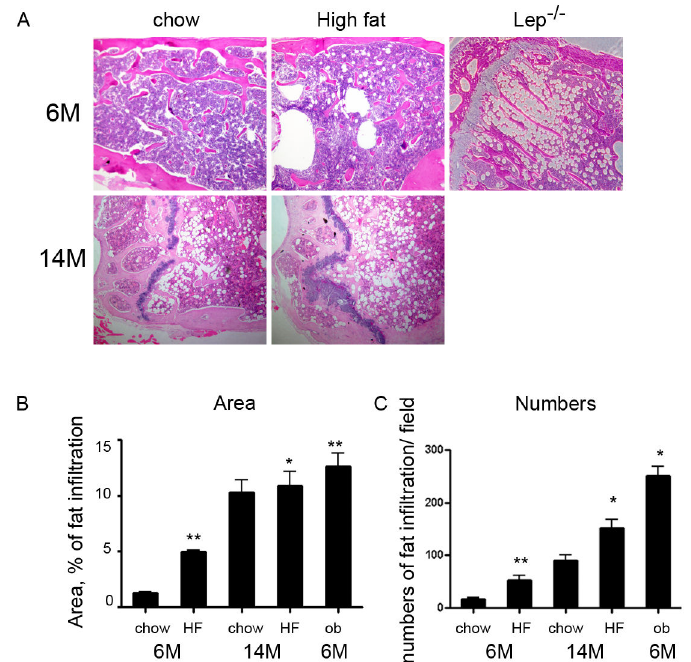
Figure 1. Quantitative analysis of bone marrow adipocytes. (a) Histology of the distal femurs of mice stained with hematoxylin and eosin. The top panels are from 6-month-old C57BL/6J male mice fed standard chow or high fat diet, and from 6-month-old ob/ob mice. The bottom panels are sections of distal femurs stained with hematoxylin and eosin from 14-month-old mice fed either standard chow or high fat diet. (b) Area of bone marrow fat infiltration as a % of total area. (c) Numbers of bone marrow fat cells (numbers/mm 2 bone marrow). Fields were taken from distal femur sections of 6-month-old (C57BL/6J and ob/ob ) and 14-month-old mice and calculated using ImagePro software. Data are mean ± SE of 6 to 10 mice per age group. * P < 0.05, ** P< 0.001 HFD vs. chow diet and ob/ob vs chow-fed 6-month old. P value was calculated by two tailed T-test. doi: